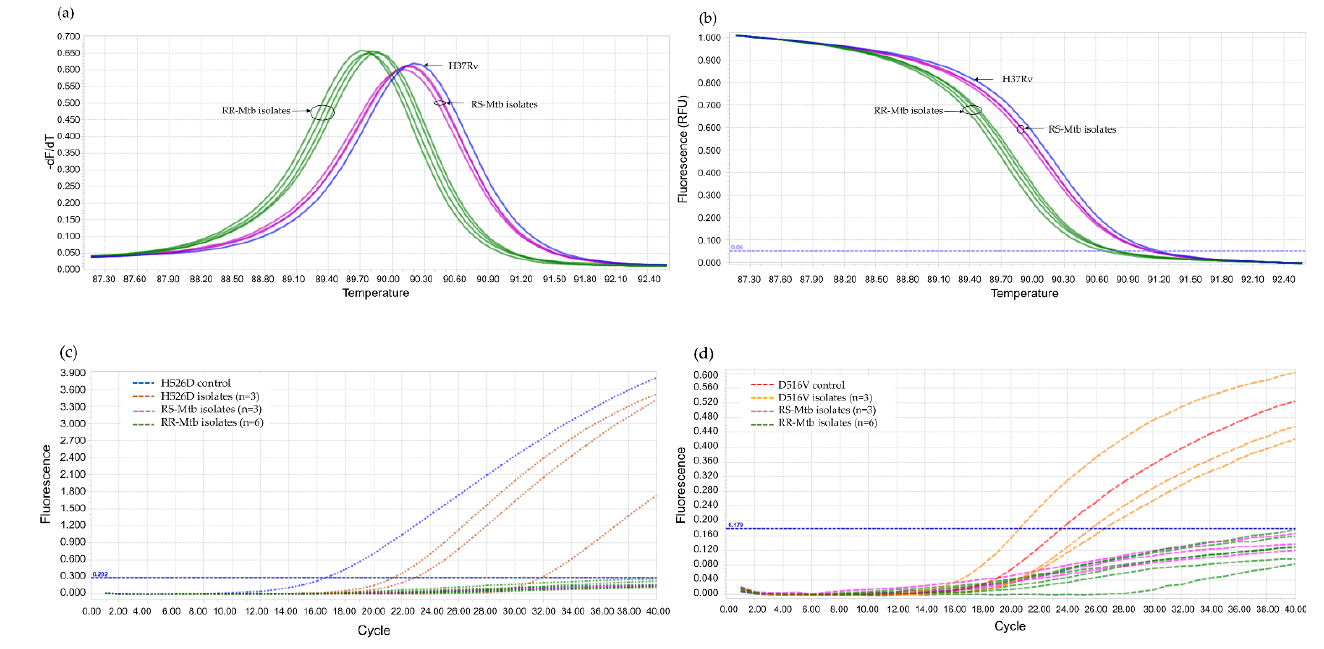
Figure 5. The performance of the RIF-RDp assay in the detection of rifampicin-resistant M. tuberculosis (RR-Mtb). The normalized melting peaks ( a ), and normalized melting curves ( b ) clearly distinguished RR-Mtb from rifampicin-susceptible M. tuberculosis (RS-Mtb) isolates based on HRM analysis. RR-Mtb strains harboring H526D or D516V mutation were detected in the HEX ( c ) or Cy5 channels ( d ), respectively. Table 2. Comparison of the performance between the RIF ‐ RDp assay and Anyplex™ II MTB/MDR in the detection of rifampicin ‐ resistant tuberculosis against drug susceptibility testing (DST) and DNA sequencing method.